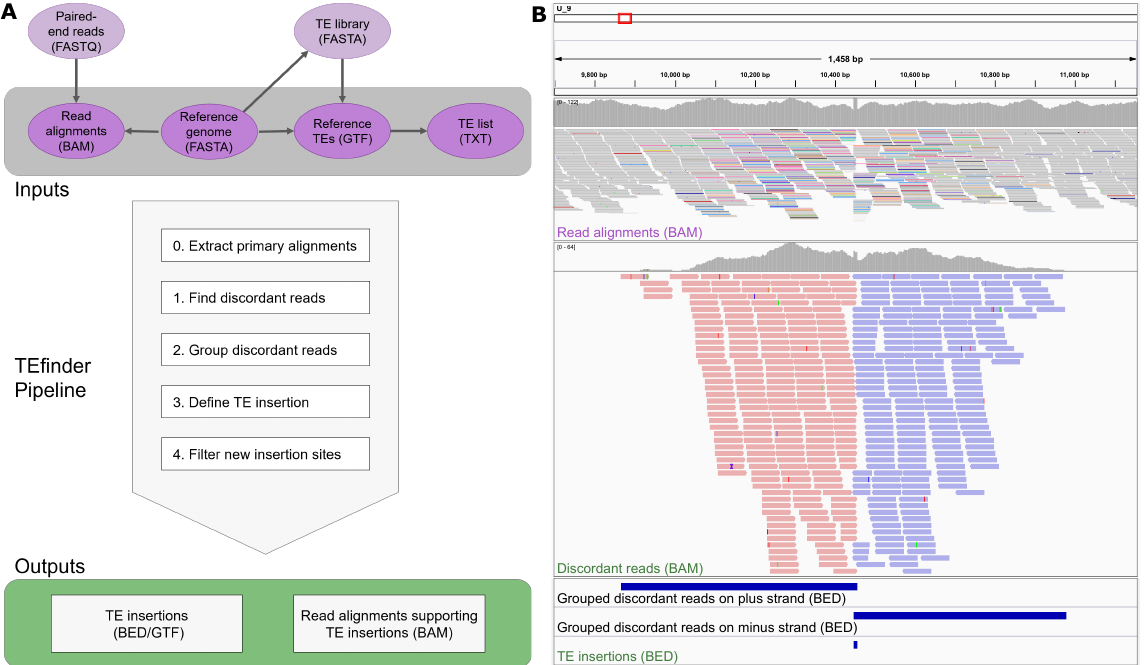
Figure 1. ( A ) Basic workflow of the TEfinder pipeline. The required input files are in dark purple, while other files that are used to create the input files are in light purple. Arrows show the dependencies of the files. Please check Implementation for details. The steps of the pipeline are in the light gray box and the outputs are in the green box. ( B ) Visualization of a new small Hornet (TIR/hAT) insertion event using Integrative Genomics Viewer (IGV). The data were derived from the Y3 population after a short-term evolution experiment using Fol4287. ( Top ) input read alignments file, ( middle ) output discordant reads alignment file, and ( bottom ) intermediate and output BED files are displayed. The aligned reads in the top panel are shown in squished mode with reads mapped to different sequences colored non-gray. The aligned reads in the middle panel are shown in collapsed mode and forward reads are in red while reverse reads are in blue. The histograms above the alignments in the top and middle panels show the aligned read counts. The position of the insertion event reported by TEfinder coincides with the duplicated target site